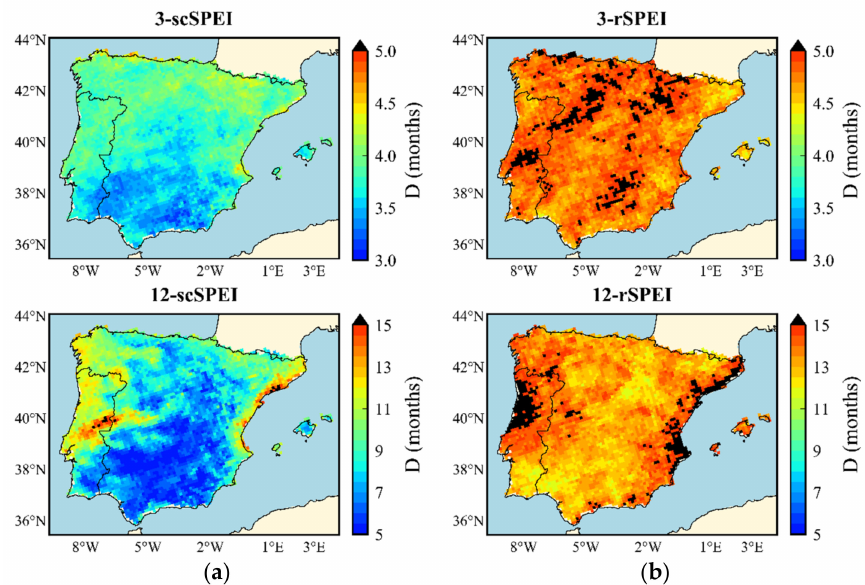
Figure 3. Multi-model ensemble mean of the mean drought duration (D, expressed in months) for indices computed at 3- and 12-month timescales for the recent past for ( a ) scSPEI (using 1980–2099 as reference period), and ( b ) rSPEI (with 1980–2009 as reference